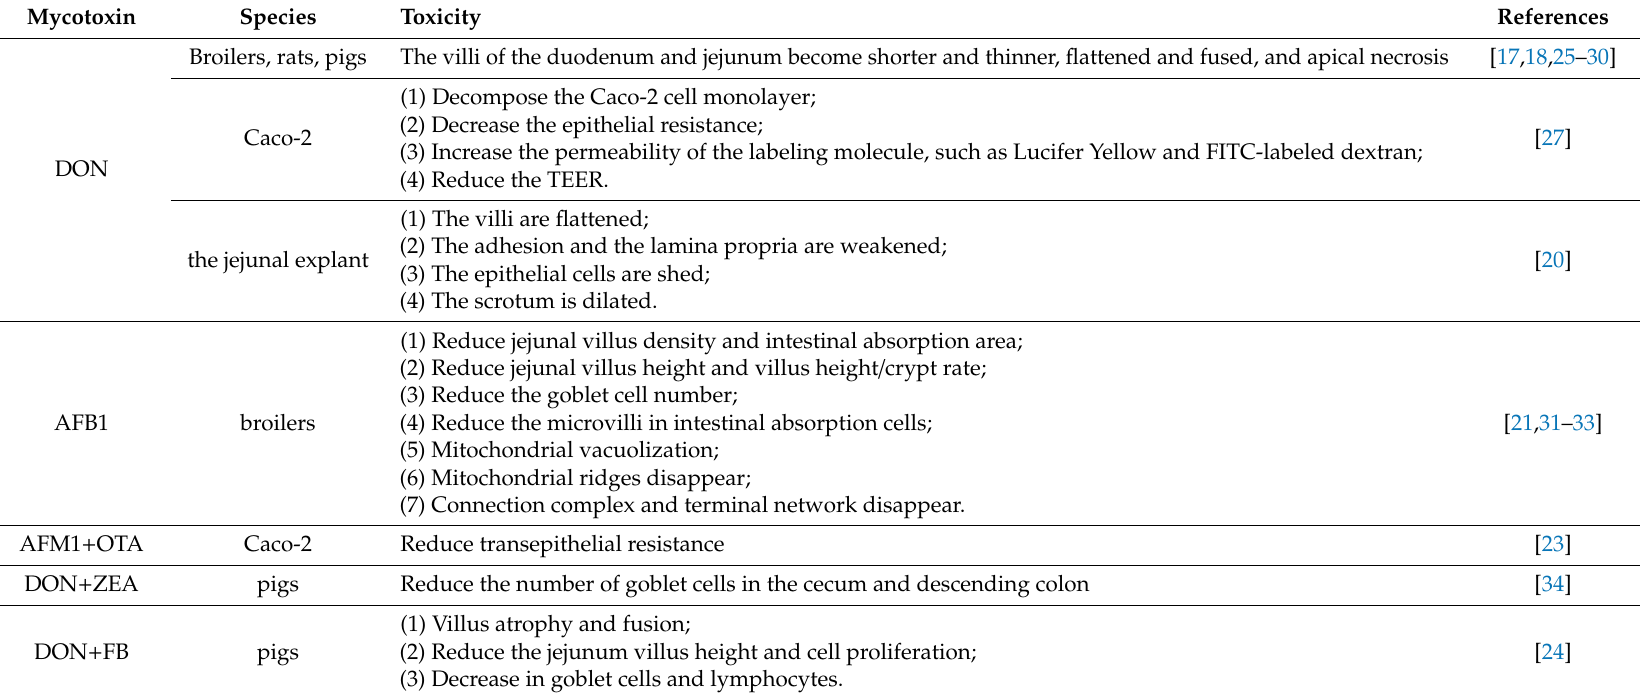
Table 2. Toxicity studies: The toxic e ff ects of mycotoxins on the morphological structure of the